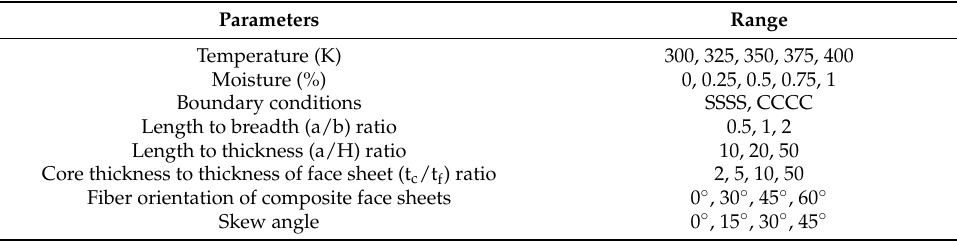
Table 5. Parameters considered for the